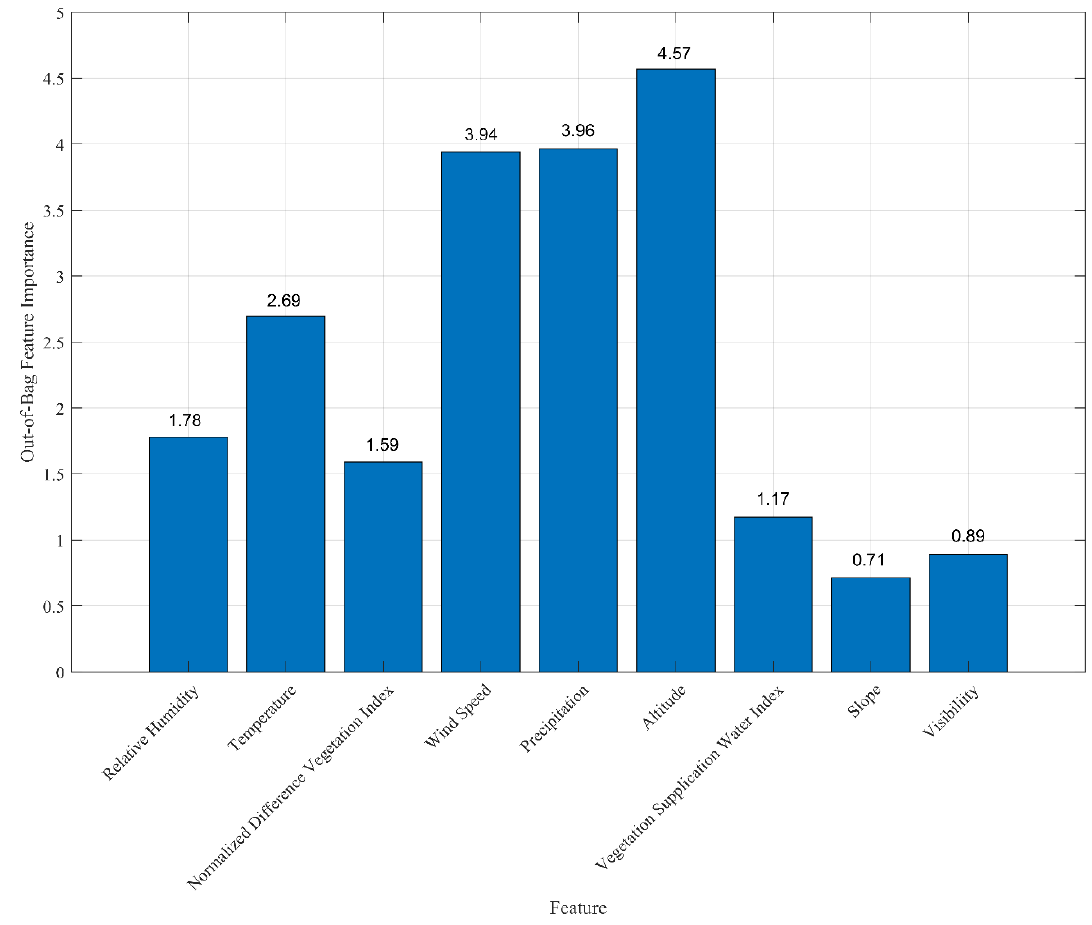
Figure 2. Importance of factors to the fire